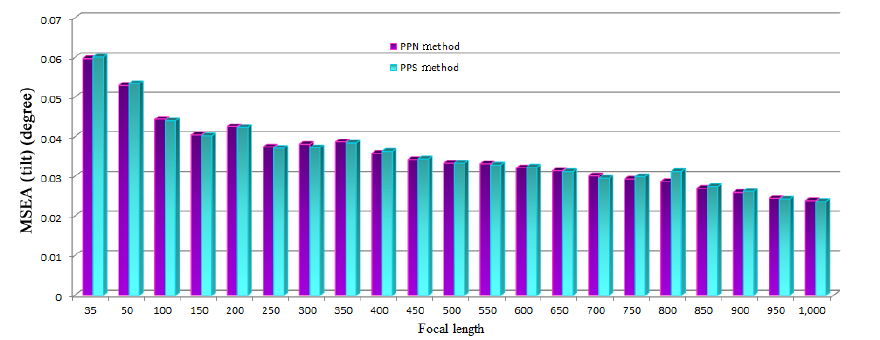
Fig. 9 Mean square error of tilt (MSEA in degrees) for two perspective techniques applied on the sphere for different focal lengths. The error in estimated tilt angle decreases with increasing focal length.